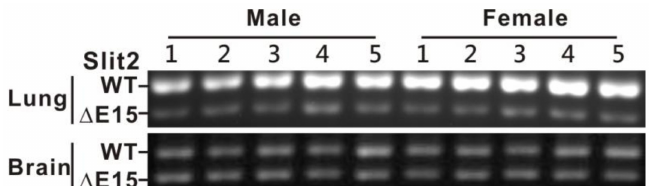
Figure 2. Expressions of Slit2-exon15 isoforms in the lungs and brains of nude mice. In the lungs, there is a higher expression of Slit2-WT than Slit2- ∆ E15 in both males and females. In the brain, Slit2-WT and Slit2- ∆ E15 are expressed at equivalent levels.